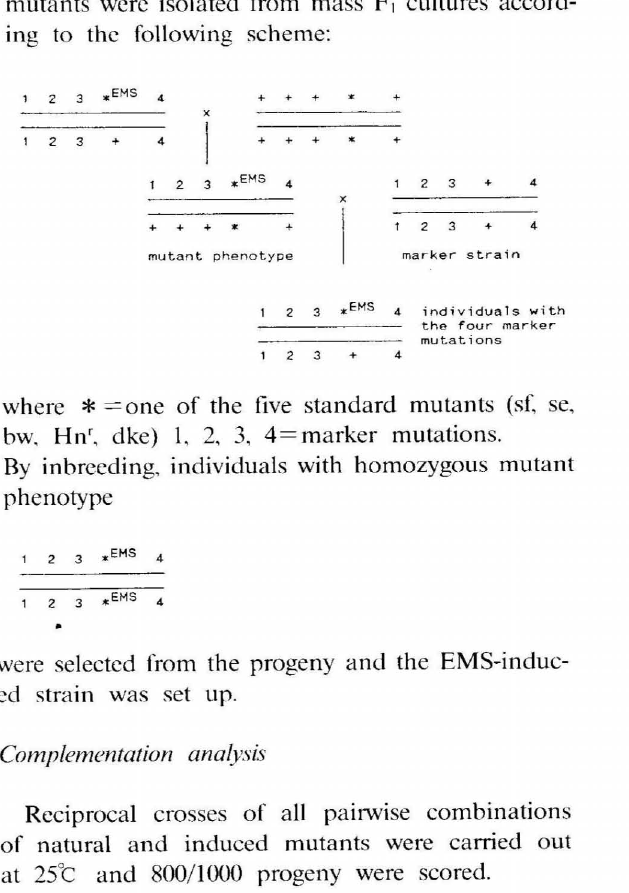
Figure I. Proposed pathway for pteridinc hiosynthesis in Dro sophila